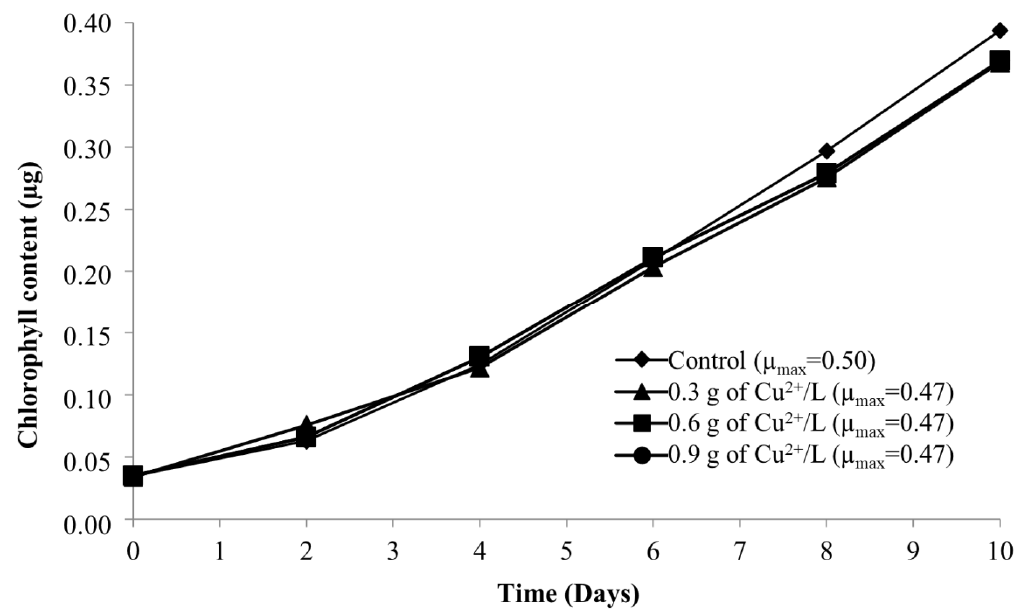
Figure 1. C . protothecoides growth curves. Figure 1. C. protothecoides growth